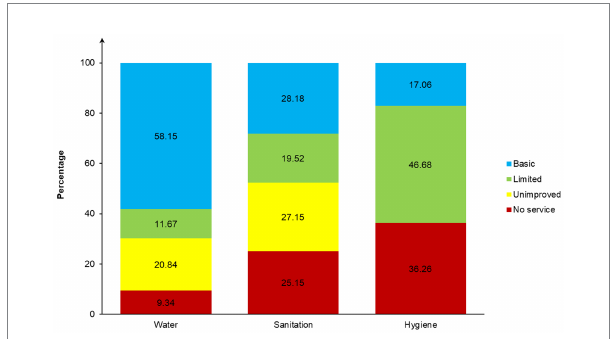
FIGURE 2 Distribution of children by access to household WASH services in SSA, 2010–21.